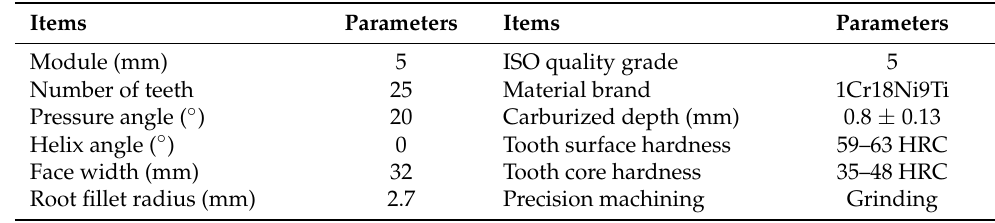
Figure 15. Gear bending fatigue test: ( a ) test platform; ( b ) vibration monitoring; ( c ) revolution counter; ( d ) loading device; ( e ) acceleration sensor; ( f ) gear sample; ( g ) gear installation; ( h ) root crack; ( i ) fracture morphology. Table 5. Parameter list of test gear.